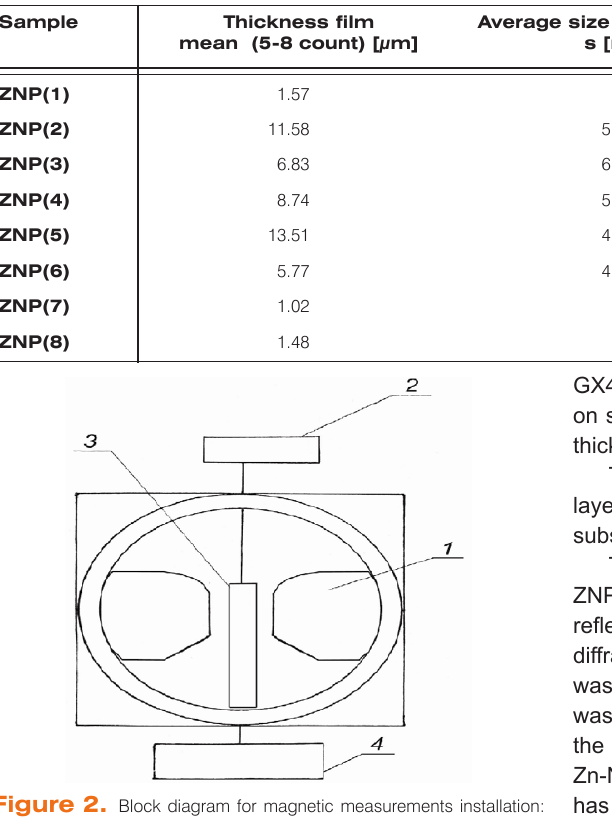
Table 3. Thickness of Ni-Zn-P film at Cu